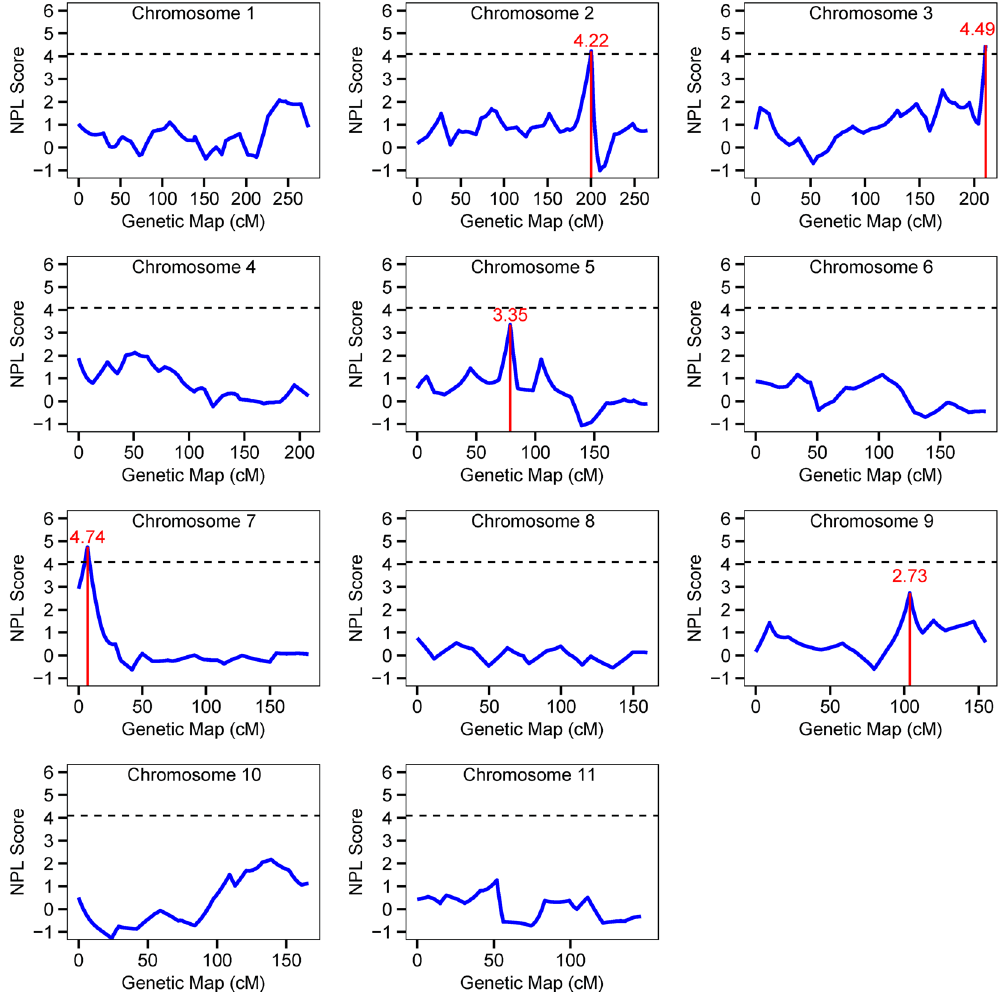
Figure 2. Genome-Wide Linkage Scan of Chromosomes 1–11 for CAD in 24 Large GeneQuest II families. X-axis and Y-axis indicate the genetic map of each chromosome and NPL scores from multipoint linkage analysis as shown by blue solid line, respectively. The red vertical solid line shows a significant linkage peak identified by two-point NPL analysis. The horizontal dash line represents the threshold of significant linkage with a multipoint NPL value of ≥